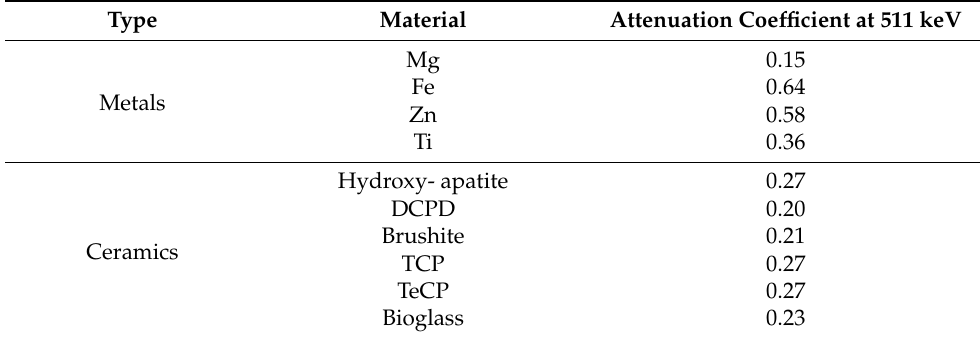
Table 3. Biodegradable implant materials and their linear attenuation coefficients (cm − 1 ) of 511 keV photons.